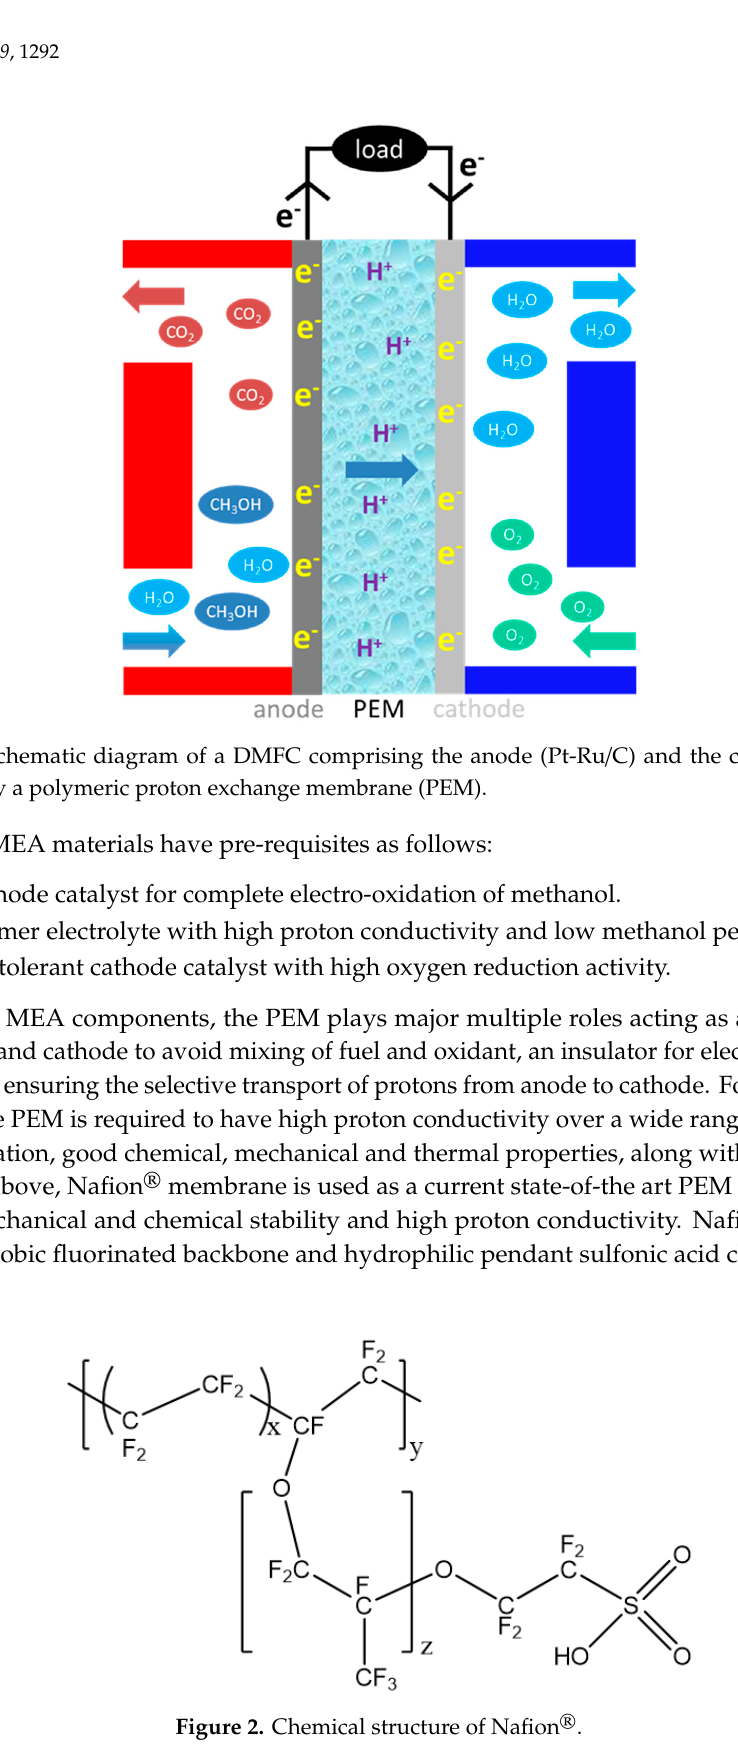
Figure 2. Chemical structure of Nafion ® .